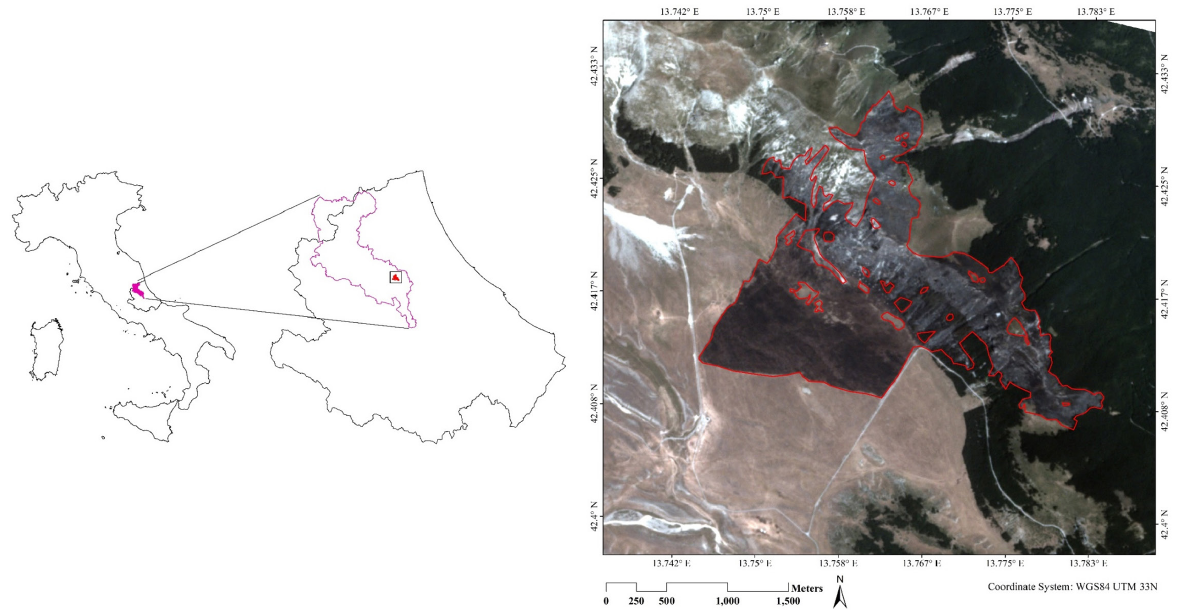
Figure 1. Map of the study area. Burned scar framed through Planet Scope image of 10 August 2017. Fire area perimeters are marked in